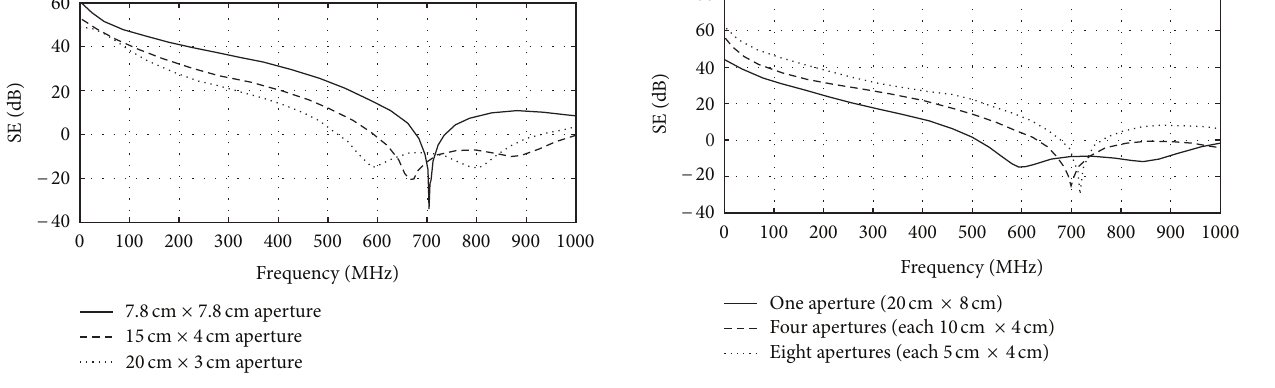
F 12: Shielding effectiveness versus frequency for a box- shaped enclosure of dimensions 30 with a single slot 12 30cm number of rectangular 3 × ×